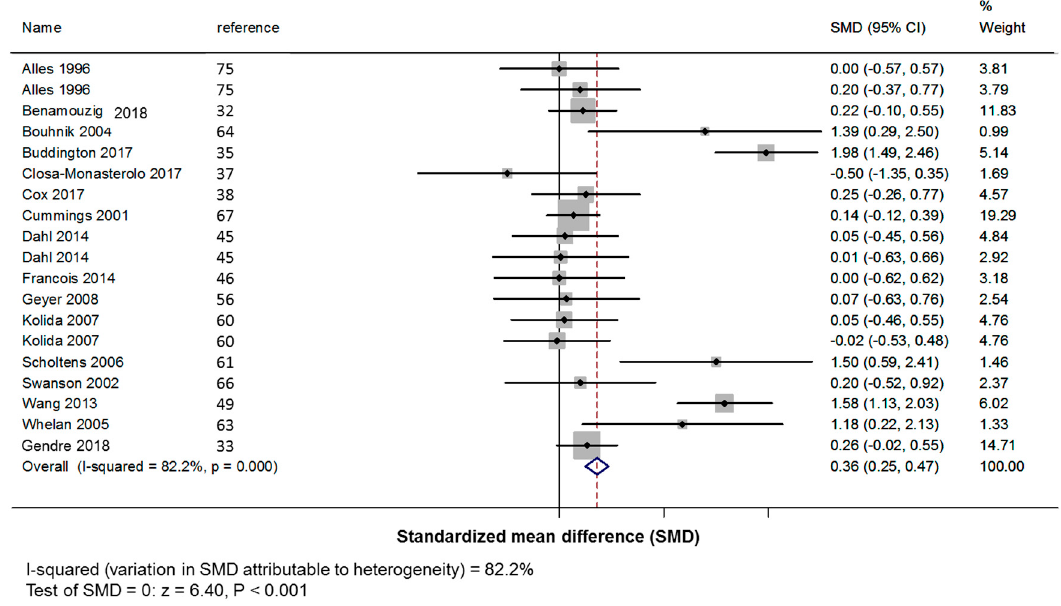
Figure 3. Forest plot for the effect of short-chain β -fructans (DP < 10) on stool frequency. SMD: standardized mean difference (number of bowel movements / day); CI: confidence interval.